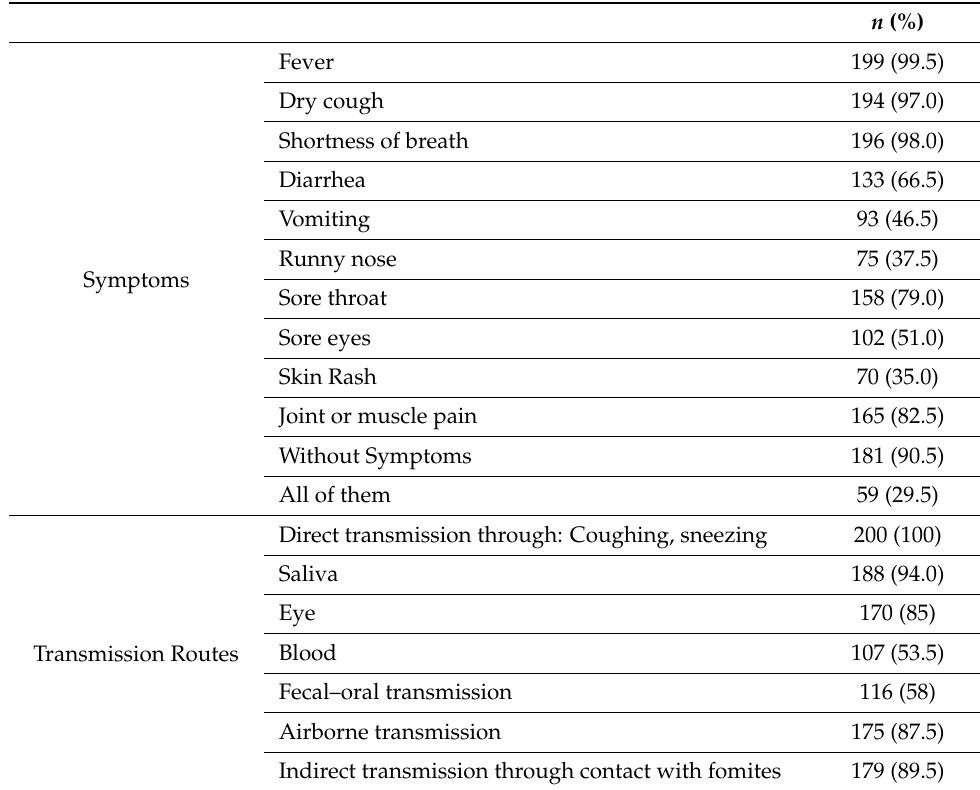
Table 3. Knowledge of participants related to symptoms and transmission routes of